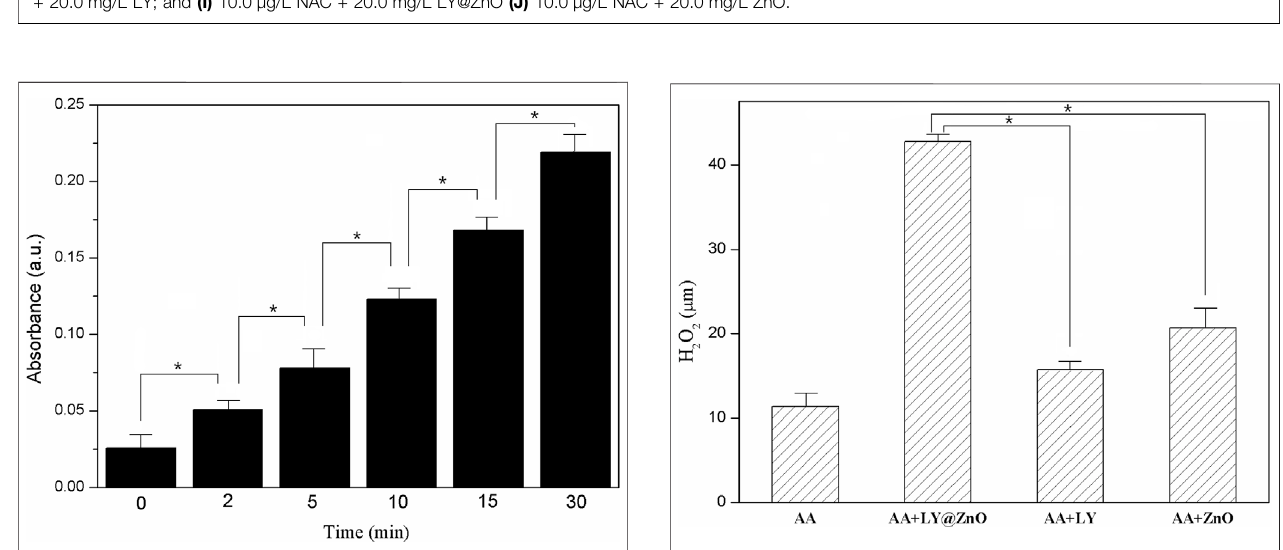
FIGURE 10 | The qualitative measurement to determine the effect of antioxidant on ROS generation in E. coli and S. aureus during 24 h (A) 0.0 mg/L LY@ZnO; (B) 5.0 mg/LLY@ZnO; (C) 10.0 mg/LLY@ZnO; (D) 20.0 mg/LLY@ZnO; (E) 20.0 mg/LZnO (F) 20.0 mg/LLY (G) 10.0 μ g/LNAC+20.0 mg/LLY@ZnO (H) 10.0 μ g/LNAC + 20.0 mg/L LY; and (I) 10.0 μ g/L NAC + 20.0 mg/L LY@ZnO (J) 10.0 μ g/L NAC + 20.0 mg/L ZnO.